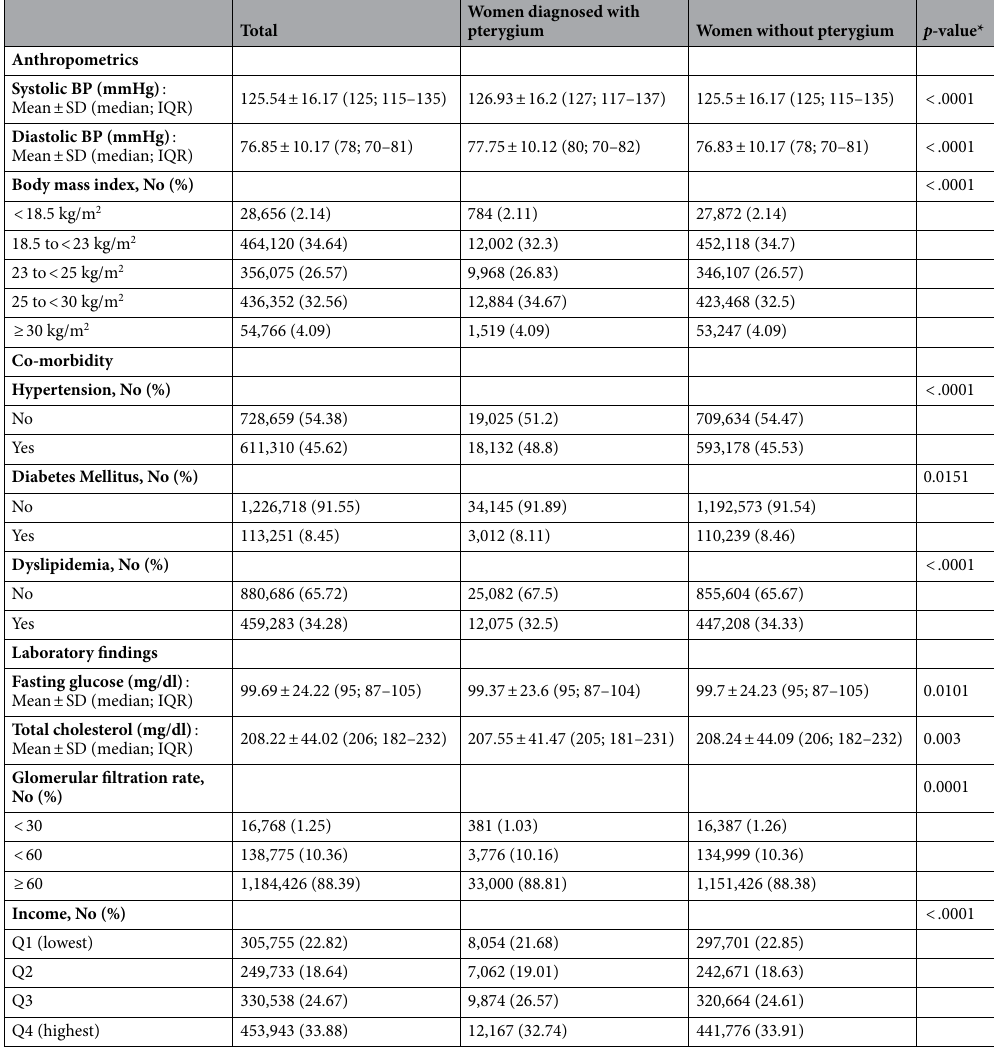
Table 1. Selected baseline characteristics of the study population. Data are expressed as (mean ± standard deviation) and (median ± interquartile range) or n (%). SD; standard deviation, IQR; interquartile range, BP; blood pressure. *Student t-test for continuous variable, Chi-squared test for discrete